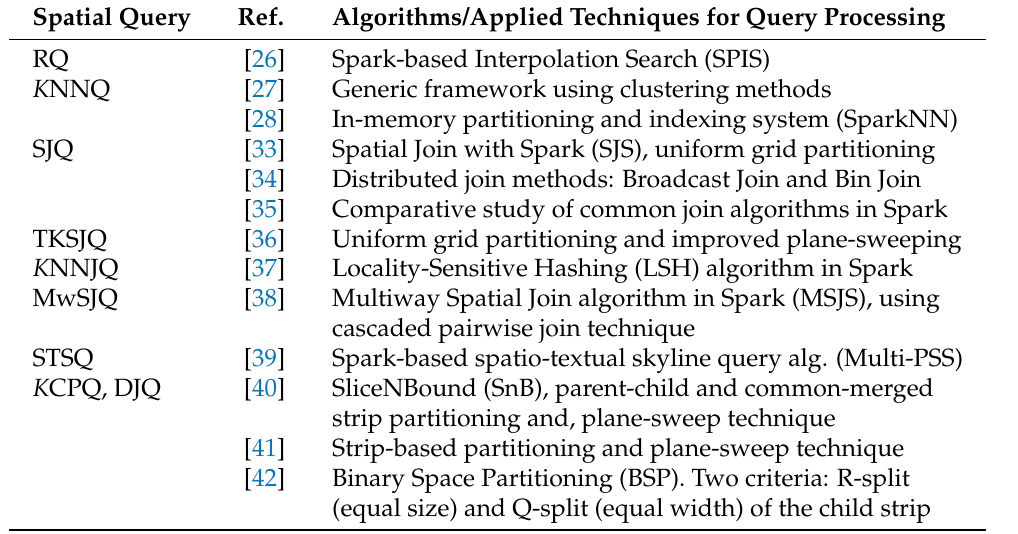
Table 2. Spatial queries implemented directly on Apache